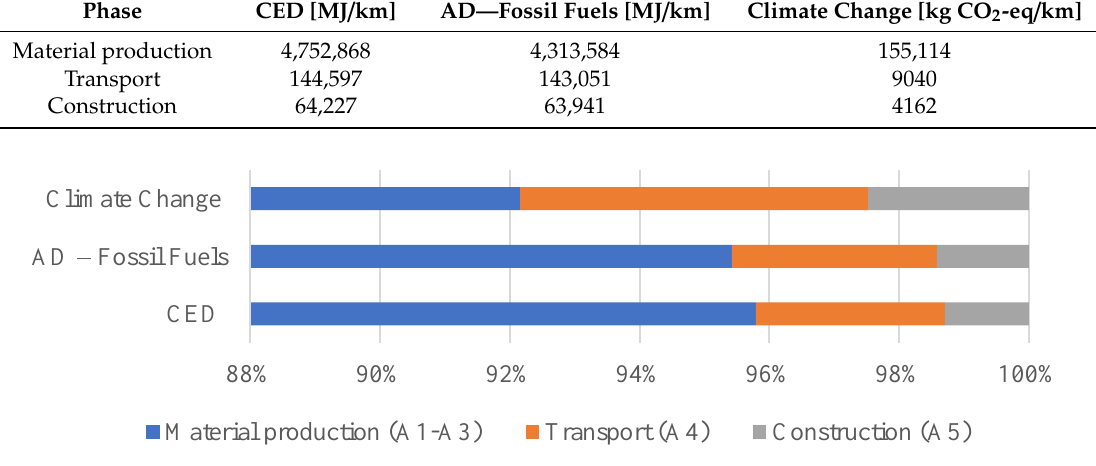
Table 10. The materials used for the construction phase.